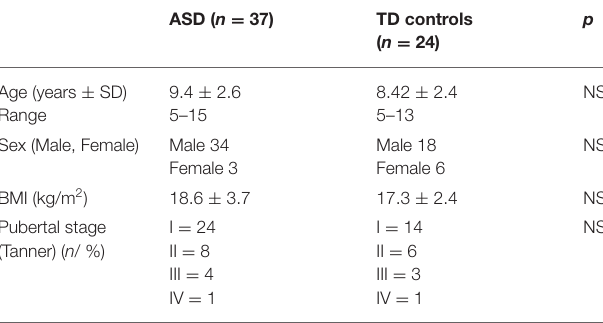
TABLE 1 | Characteristics of the